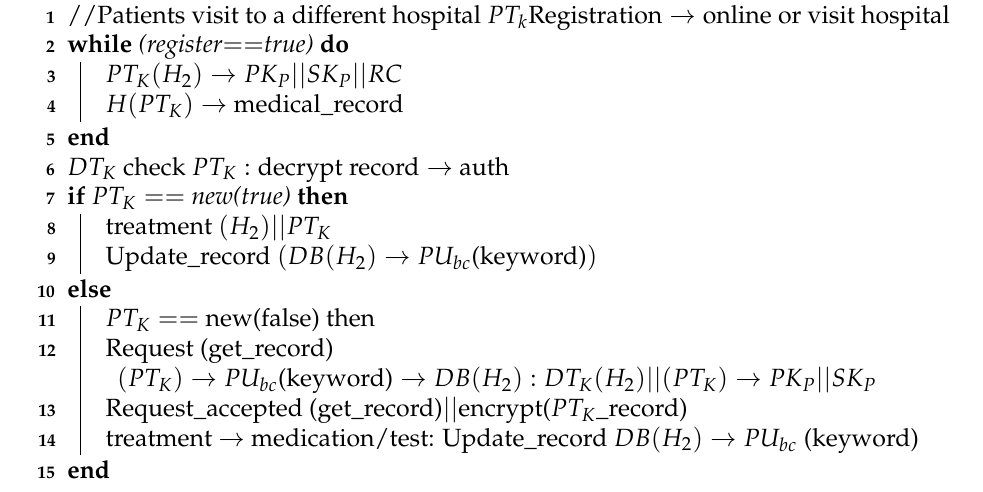
Algorithm 3: Patient’s visits to a different